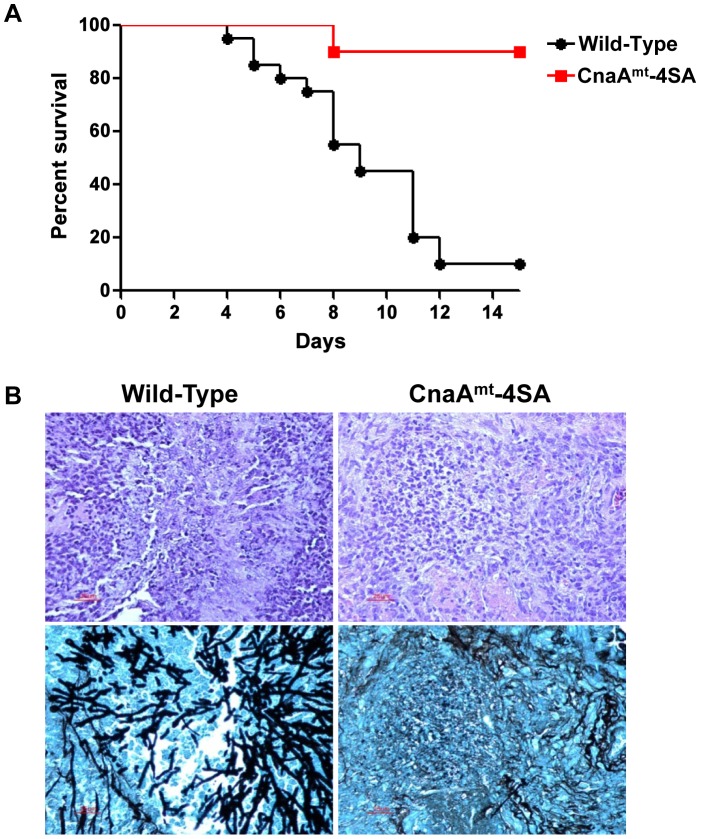
Mutation of the phosphorylated residues in the SPRR cause reduced virulence.(A) Kaplan-Meier survival curve showing virulence analysis in a murine inhalational model of invasive aspergillosis. At day 14 post-infection, mice infected with the WT strain displayed 90% mortality, in contrast to the cnaAmt-4SA strain which exhibited a significant reduction in virulence (P<0.0001). (B) Histopathological examination of the lungs shows less inflammation in the cnaAmt-4SA strain as well as significantly less hyphal invasion.